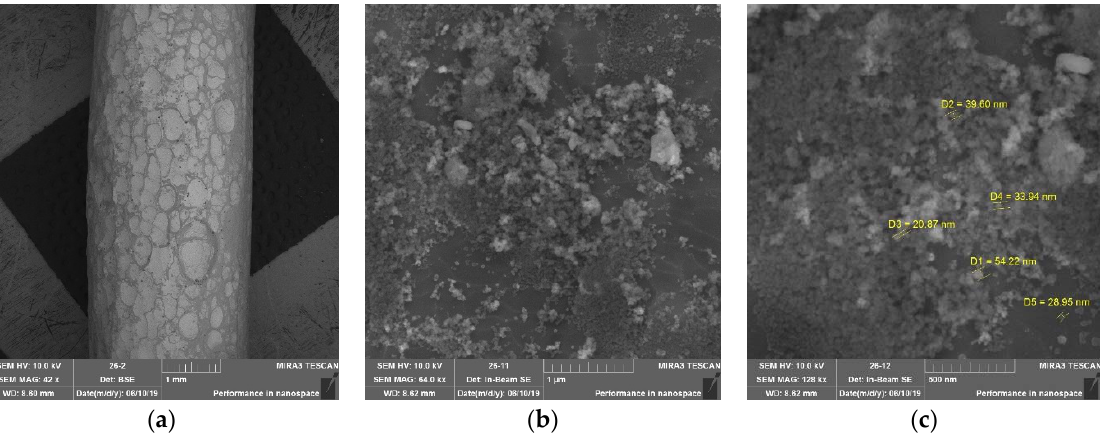
Figure 15. SEM micrographs of the surface of a sample containing three layers of protective coating applied by immersion in SiO 2 nanoparticles sol. ( a ) zoom ×44; ( b ) zoom ×100; ( c ) zoom ×64,000.